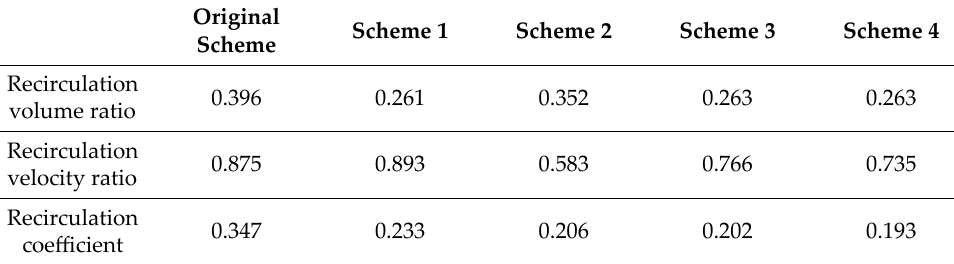
Table 3. Recirculation coefficient of each scheme.